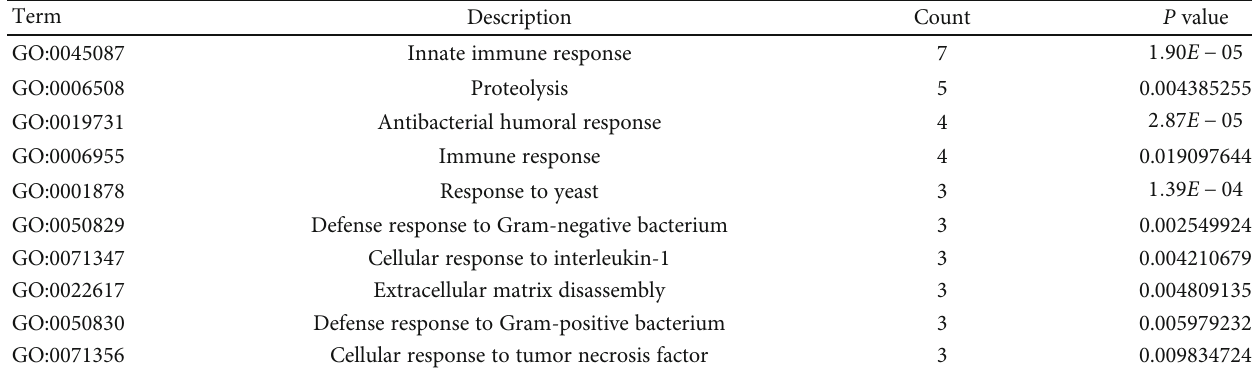
(b) Functions enriched for the genes involved in cluster